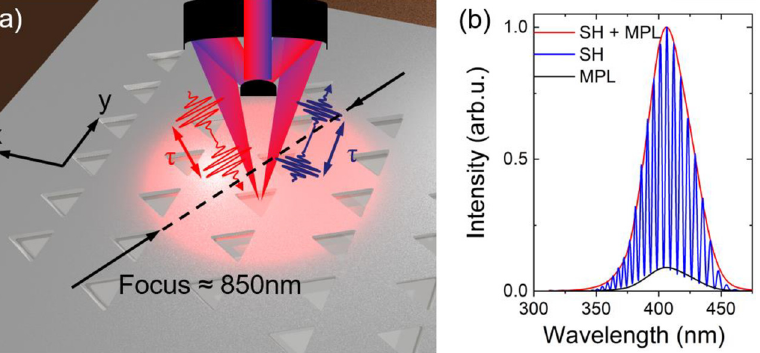
Figure 1: (a) Sketch of the confocal second harmonic (SH) microscopy technique. A dispersion-balanced pair of 6-fs-laser pulses with adjustable time delay τ derived from a Ti:Sapphire oscillator and a Mach – Zehnder interferometer is focused by an all-re fl ective Cassegrain focusing objective onto the silver fi lms containing the triangular nanocavities. The generated multiphoton photoluminescence (MPL) and SH from the samples is collected in re fl ection geometry by the same objective as a function of sampleposition and time delay τ and analyzed in a spectrometer. (b) A prototypical spectrum taken at a position inside the triangular hole pattern. The signal consists of coherent SH and incoherent MPL emission. The blue line represents the measured spectrum showing the modulated SH emission between the red and black line and the black line represents the weak, spectrally unmodulated